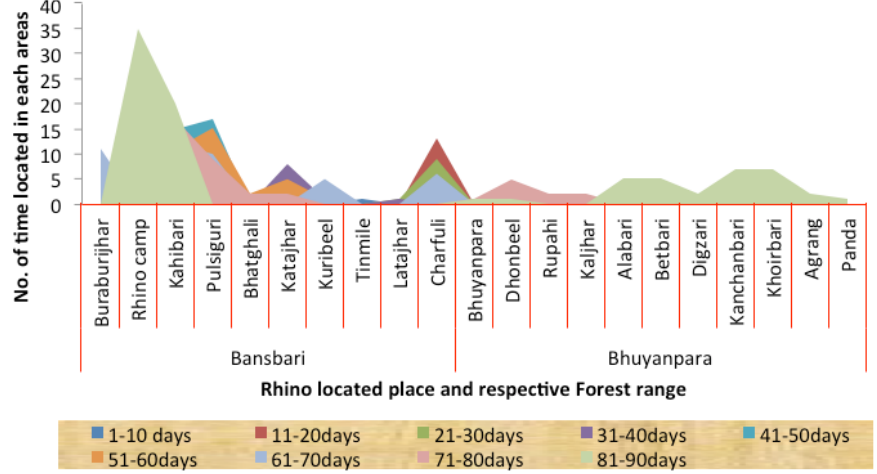
Figure 5. Colonization pattern of the 1 st group of Rhino